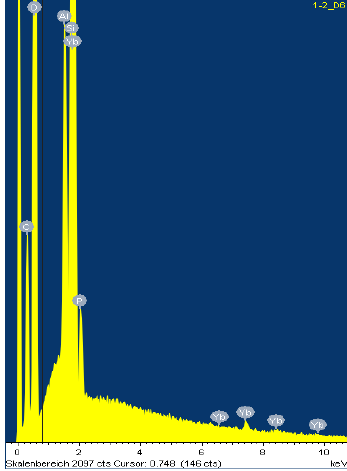
Figure 6. EDX spectrum from sol-gel derived vitrified glass. The carbon (C) peak is due to the carbon-coating applied for EDX sample preparation [7]. Table 3. EDX measurement: Element doping ratio in mass percentage (including oxygen).